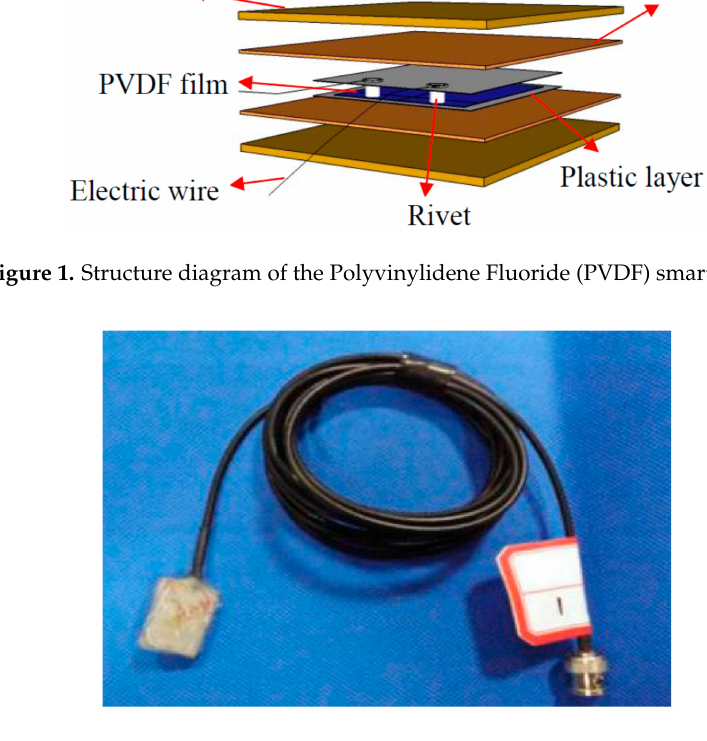
Figure 2. The PVDF smart sensor.